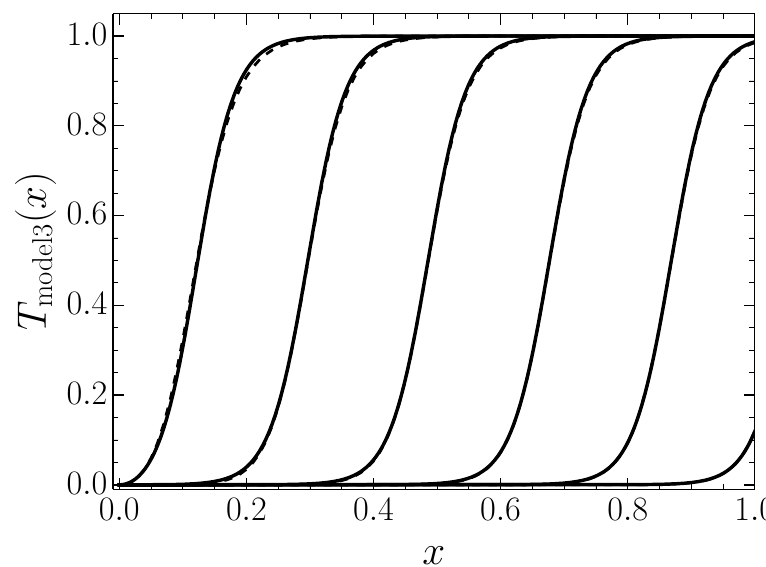
Figure 8. Regge–Wheeler for Schwarzschild: Scalar greybody factors . Toy model # 3, Equation (41), for the scalar greybody factors compared to the numerical data. From left to right the curves correspond to (cid:96) = 0 to (cid:96) = 5. Note the solid curves are the numerical data, while the dashed curves are from our model # 3. The curves are often indistinguishable to the naked eye.